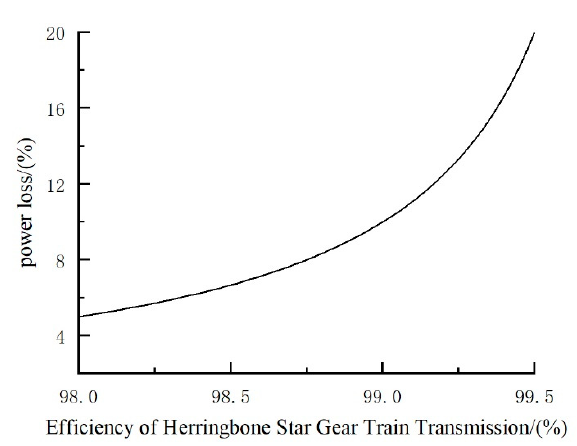
Figure 1. Power loss ratio at different efficiencies.